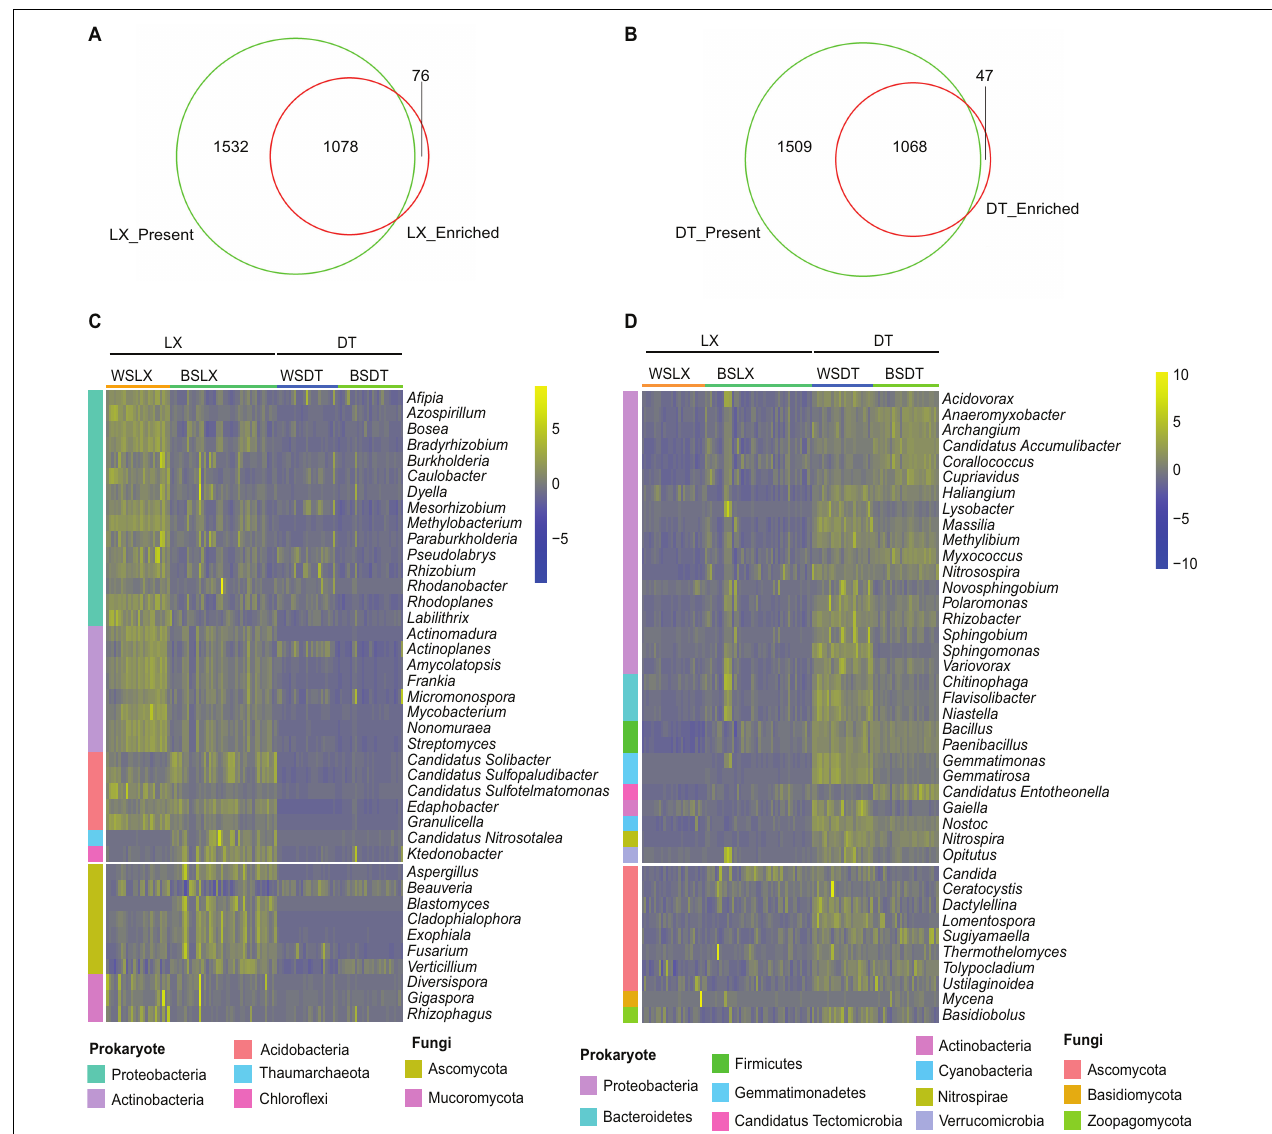
FIGURE 4 | Characterization of the core P. notoginseng rhizosphere microbes in cropland planting ( n = 52) and understory planting ( n = 70) patterns. (A) Venn plot depicting the number of core rhizosphere genera based on the presence rate ( > 75%) in all understory planting samples and the genus have a higher relative abundance in understory planting than in cropland planting. (B) Venn plot depicting the number of core rhizosphere genera based on the presence rate ( > 75%) in all cropland planting samples and the genus have a higher relative abundance in cropland planting than in understory planting. (C,D) Relative abundances of the 30 prokaryotes and 10 fungi, most relatively abundant core rhizosphere genera in cropland planting and understory planting patterns based on metagenomic data. Scale, relative abundance of genus at row normalization by removing the mean (centering) and dividing by the standard deviation (scaling). The color from blue to yellow represents a relative abundance of each taxa from low to high. WS, Wenshan City; BS, Baise City; DT, cropland planting rhizosphere soil; LX, understory planting rhizosphere